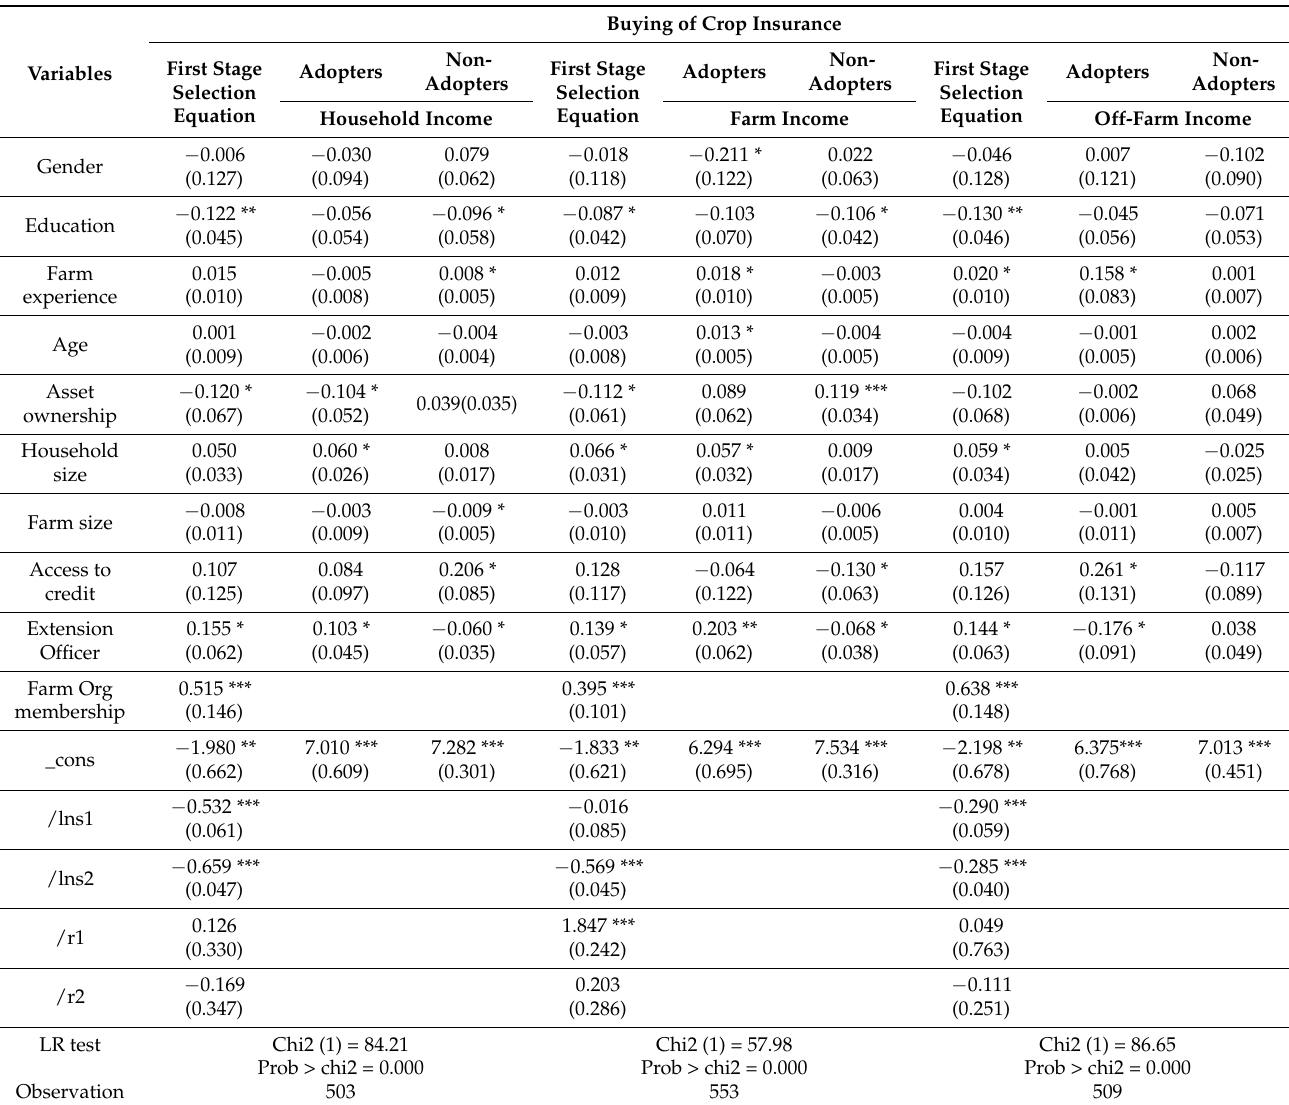
Table 7. Endogenous switch regression model estimation on adoption of crop insurance on income levels of cocoa